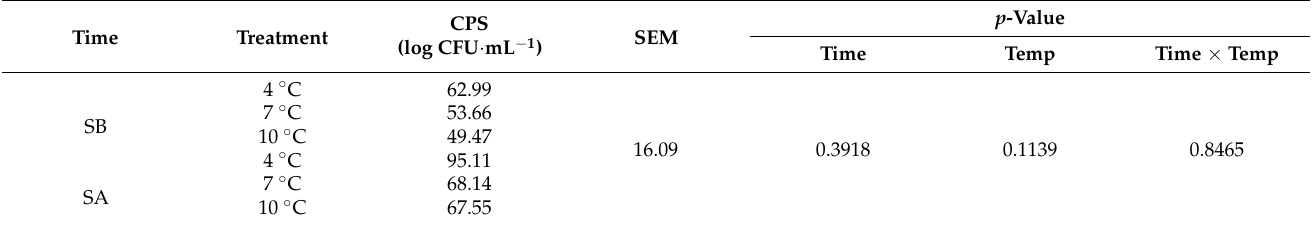
Table 3. Effects of immersion of rabbit carcasses in the pre-chiller, water temperature, and their interaction on the mean count of coagulase-positive Staphylococcus